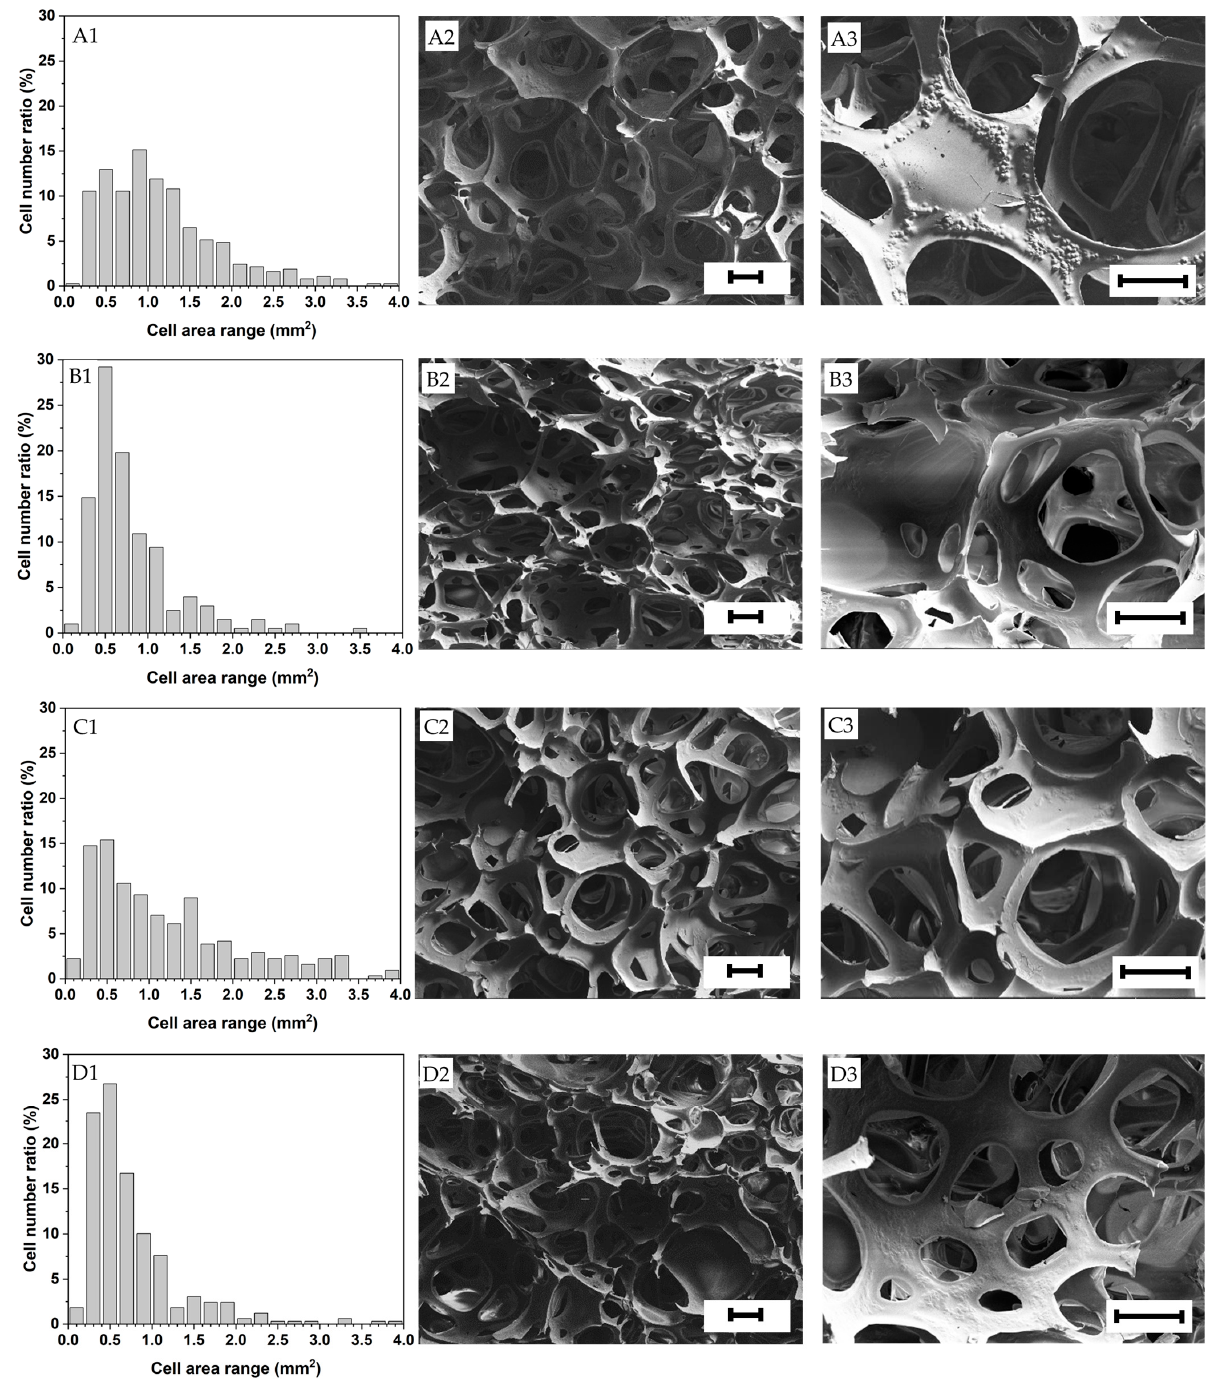
Figure 5. Cell area distribution and structure of the foams investigated ( A ) Native tapioca, ( B ) Pre- gelatinized tapioca, ( C ) Native corn, ( D ) Pregelatinized corn. Scale bar = 200 μ m. Lower mean pore areas and narrower cell area distributions generally led to higher bulk densities. The 25 wt.% solid content foams made solely with gelatin presented the smallest mean cell area (0.775 mm 2 ). This is attributed to their faster gelation than the rest of the foams due to their higher gelatin content (the other formulations had 20 wt.% gela-